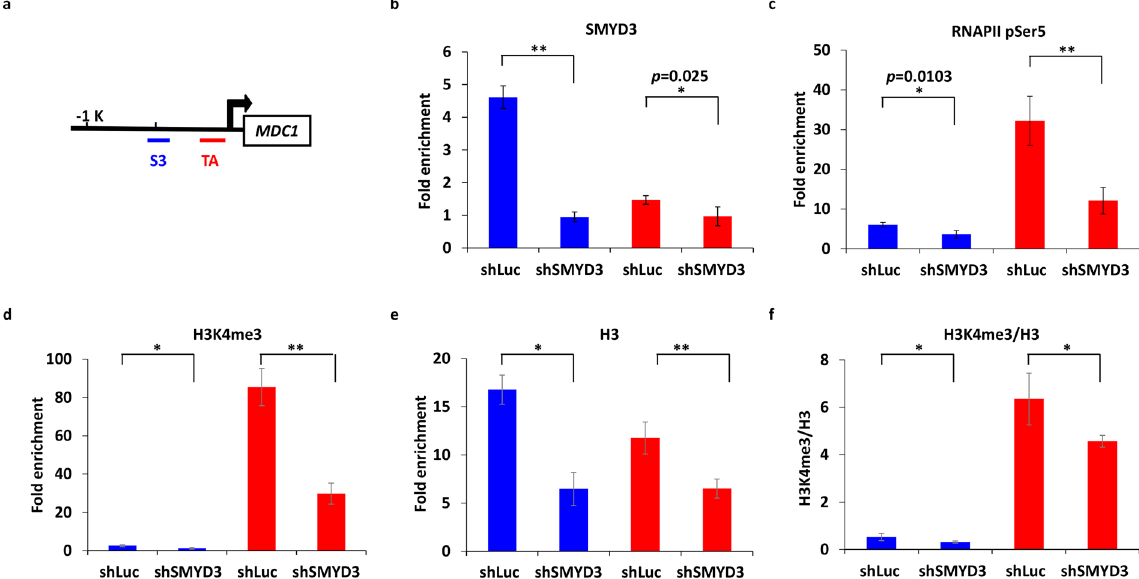
Figure 5. SMYD3 regulates the expression of MDC1 through methylating histone H3K4. ( a ) ChIP assay was performed in MCF7 cells using specific antibodies. The examined positions at the MDC1 locus were indicated, in which region S3 and region TA for the predicted SMYD3 and TATA box binding sites, respectively. ( b – e ) ChIP assays were performed with SMYD3-repressed MCF7 cells using specific antibodies shown at the top of the histogram. Fold enrichment of each antibody compared with IgG was shown. ( f ) Ratios of H3K4me3/H3 ChIP signals were displayed. In ( b – f ), immunoprecipitated chromatin was quantified by qRT-PCR. * P < 0.05. ** P < 0.01. All values in the histograms were means ± SD of triplicates and data were representative of n ≥ 3 for each